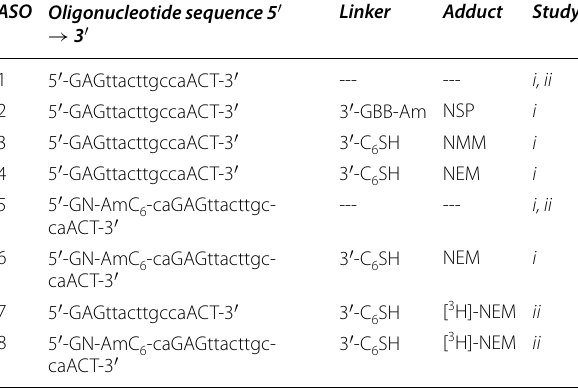
Table 1 Overview of oligonucleotides used in different proof- of-concept studies. Capital letters in sequence describe LNA- modified nucleosides, small letters describe DNA